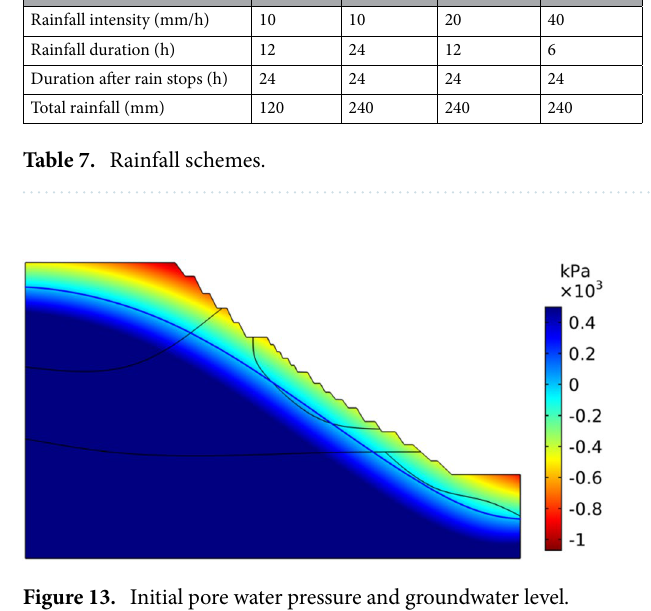
Figure 13. Initial pore water pressure and groundwater level.